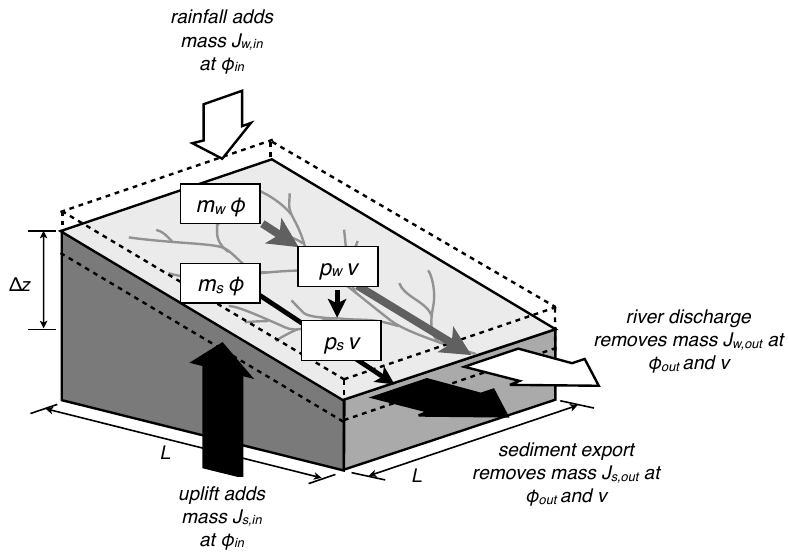
Fig. 3. Definition of a drainage system as a thermodynamic system by delineating its boundaries (dashed lines), the fluxes across the bound- aries (in terms of mass and momentum fluxes as well as their respective, conjugate variables), and the four forms of free energy considered in the simple models (potential energies m w φ , m s φ ; kinetic energies p w v , p s v ). The change in energy within the system is expressed through the respective values of the conjugate variables that convert mass and momentum fluxes to energy exchange fluxes. Ultimately, these energy fluxes set the limits to the strength of the dynamics within the